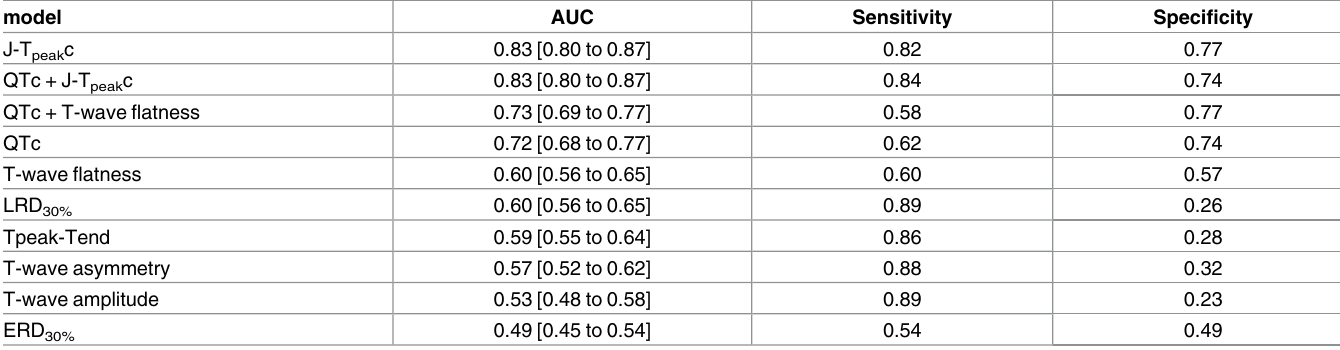
Table 4. Logistic regression by performance.